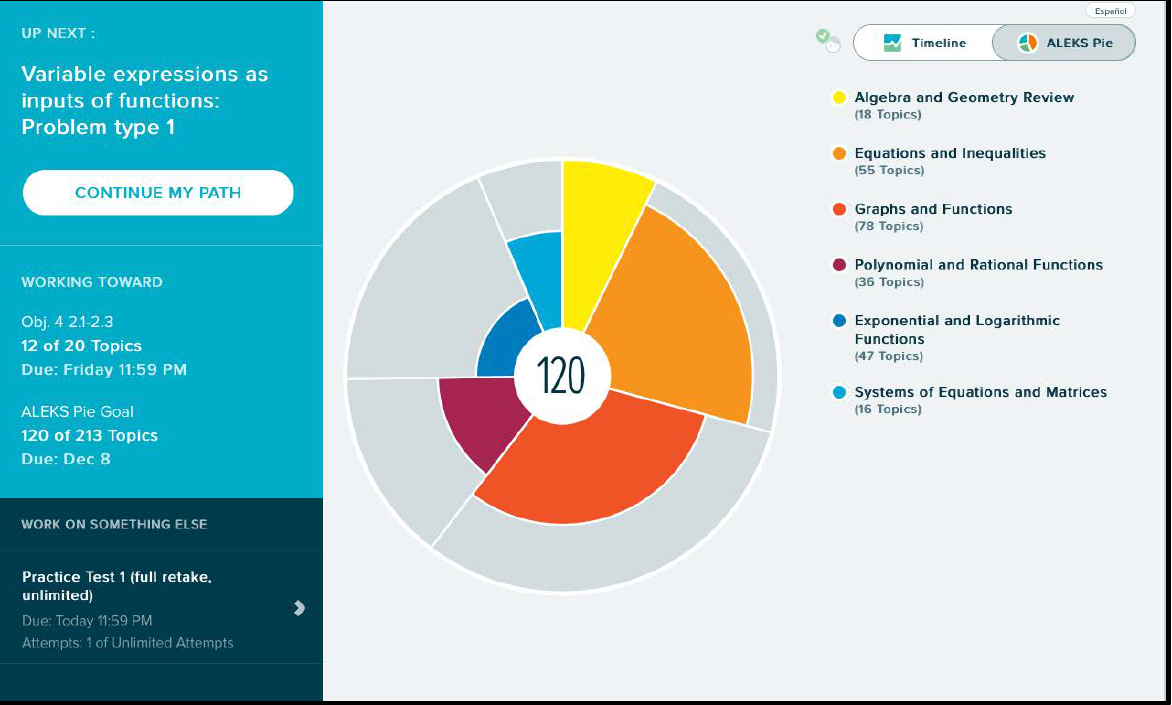
Figure 5b. A sample of the ALEKS learning pie. Adapted from MAC1105C: College Algebra , by R. Ait Maalem Lahcen, 2019, Orlando, FL: University of Central Florida. Copyright 2019 from the University of Central